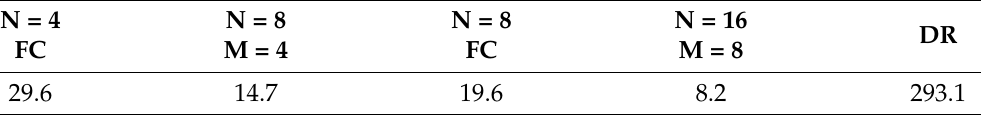
Table 2. Mean of the position RMSE in each situation using bathymetric map (unit: meters).